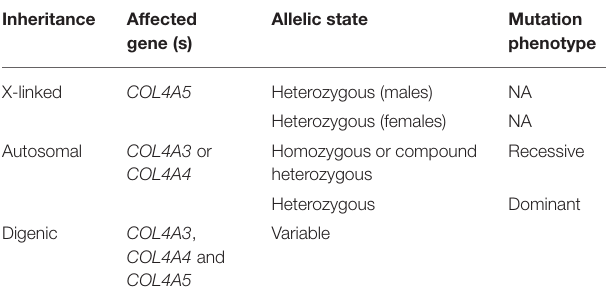
TABLE 1 | New classification system of Alport